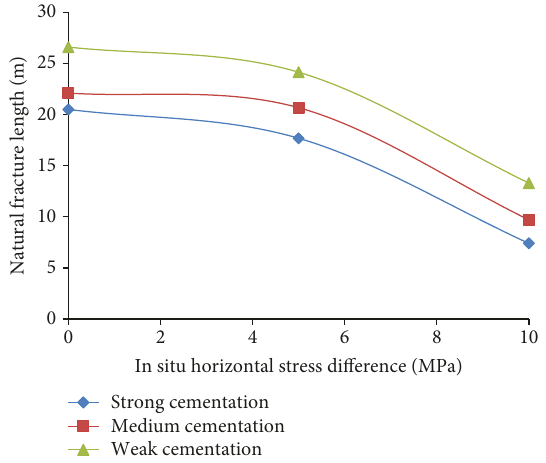
Figure 13: The in fl uence of cementation strength of a natural fracture on natural fracture